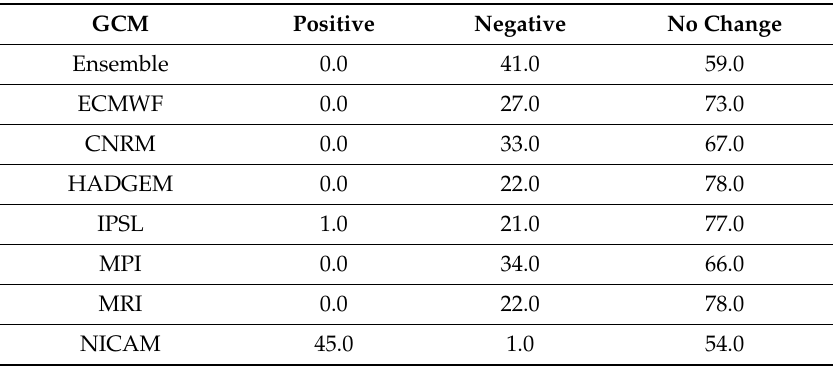
Table 3. Return level percentage grid change between the observation and